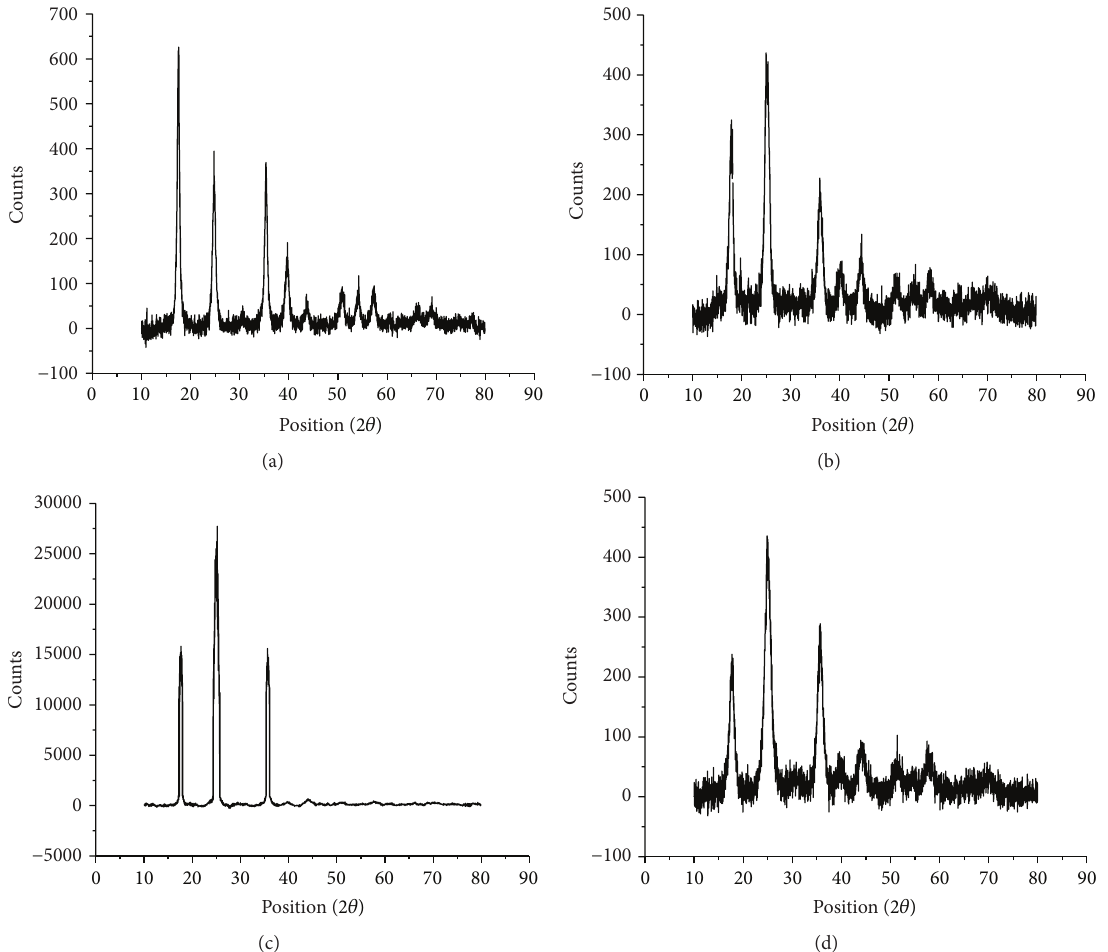
Figure 2: PXRD pattern of (a) FeHCF, (b) KCuHCF, (c) KCoHCF, and (d) KNiHCF